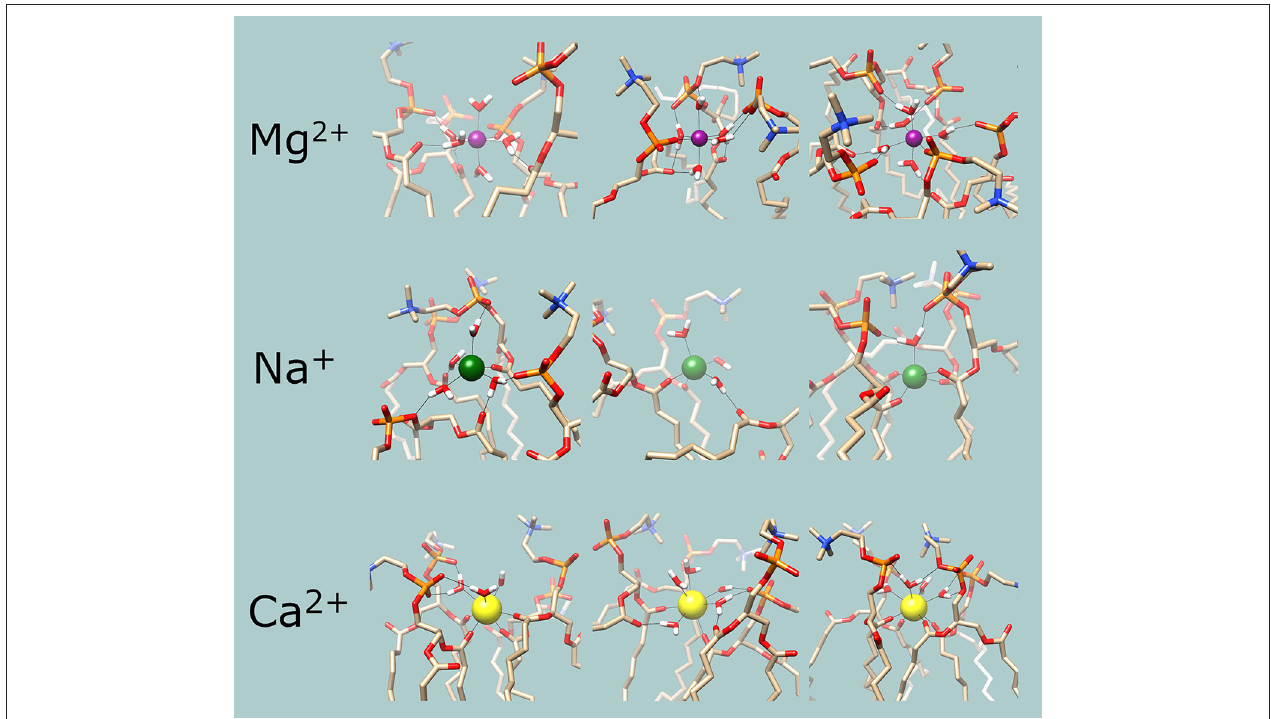
FIGURE 4 | Examples of the chemical environments of the cations. Magenta: Mg 2 + ; green: Na + ; yellow: Ca 2 + . In the lipid and water molecules, oxygen is red, nitrogen is blue, phosphorous is orange and hydrogen is white. Hydrogen and coordination bonds are identified from distance and are indicated with thin black lines.